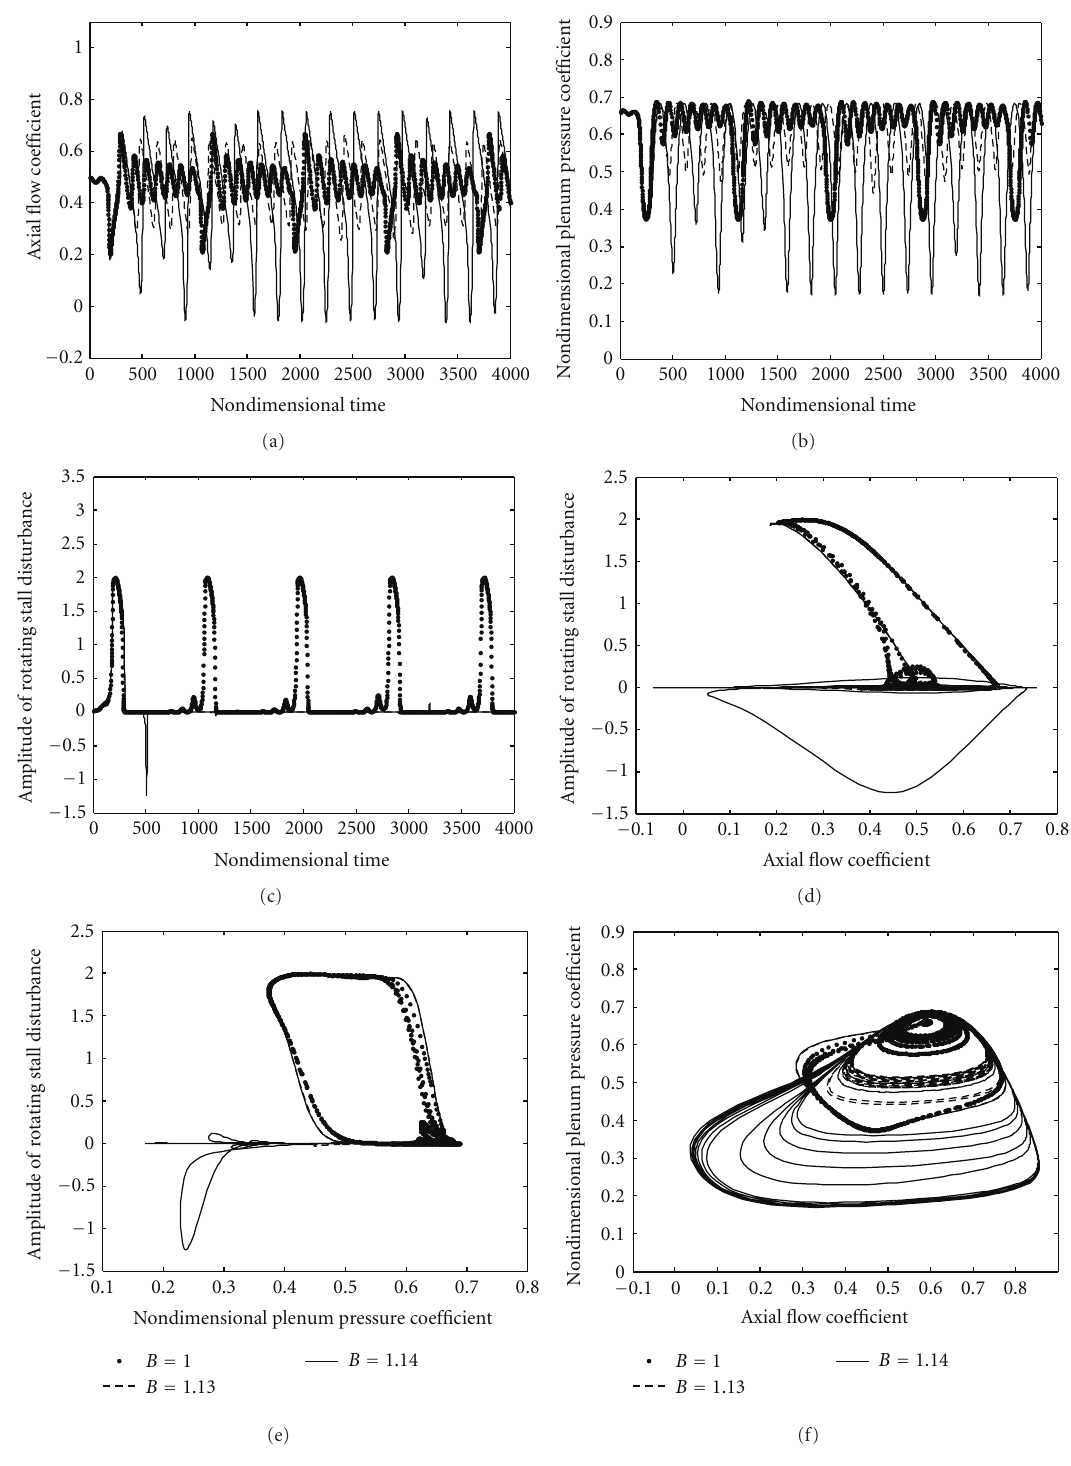
Figure 13: E ff ect of increase in B parameter from 1 to 1.14: variation of nondimensional flow properties (a), (b), and (c) with time. (a) Axial flow coe ffi cient, (b) plenum pressure rise coe ffi cient, and (c) disturbance amplitude of rotating stall. (d) Variation of axial flow coe ffi cient with disturbance amplitude of rotating stall. (e) Variation of plenum pressure rise coe ffi cient with disturbance amplitude of rotating stall. (f) Limit cycle oscillation: axial flow coe ffi cient versus plenum pressure rise coe ffi